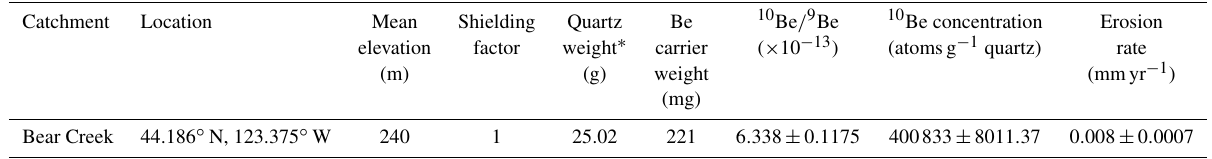
Table 4. New CRN erosion rate at Bear Creek. We used the CRONUS online calculator (Balco et al., 2008) to determine catchment-averaged erosion rates from 10 Be in stream sediment at Bear Creek. Reported CRN error is from external uncertainty. Catchment